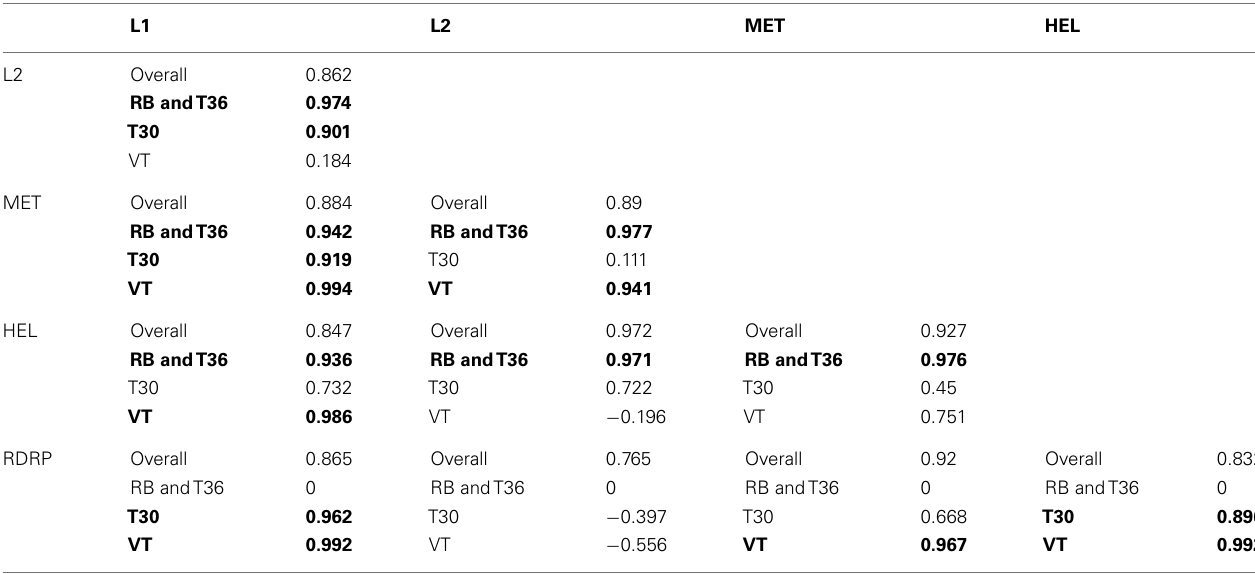
Table 6 | Strain-specific co-evolution events between recognized domains of ORF1a identified by